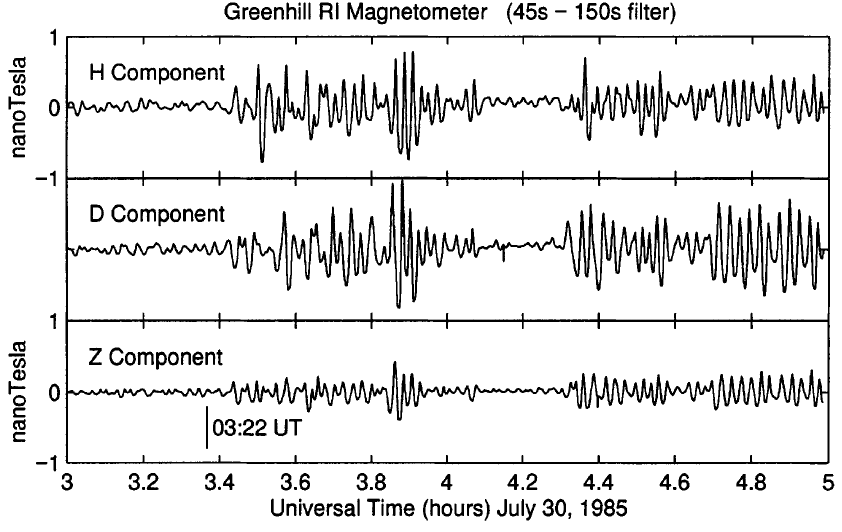
Fig. 5. Magnetic field signals filtered in the 45 s–150 s band show bursts of pulsation activity following the Shuttle-burn experi- ment at 03:22 UT. The onset of pulsation activity occurred at (cid:24)